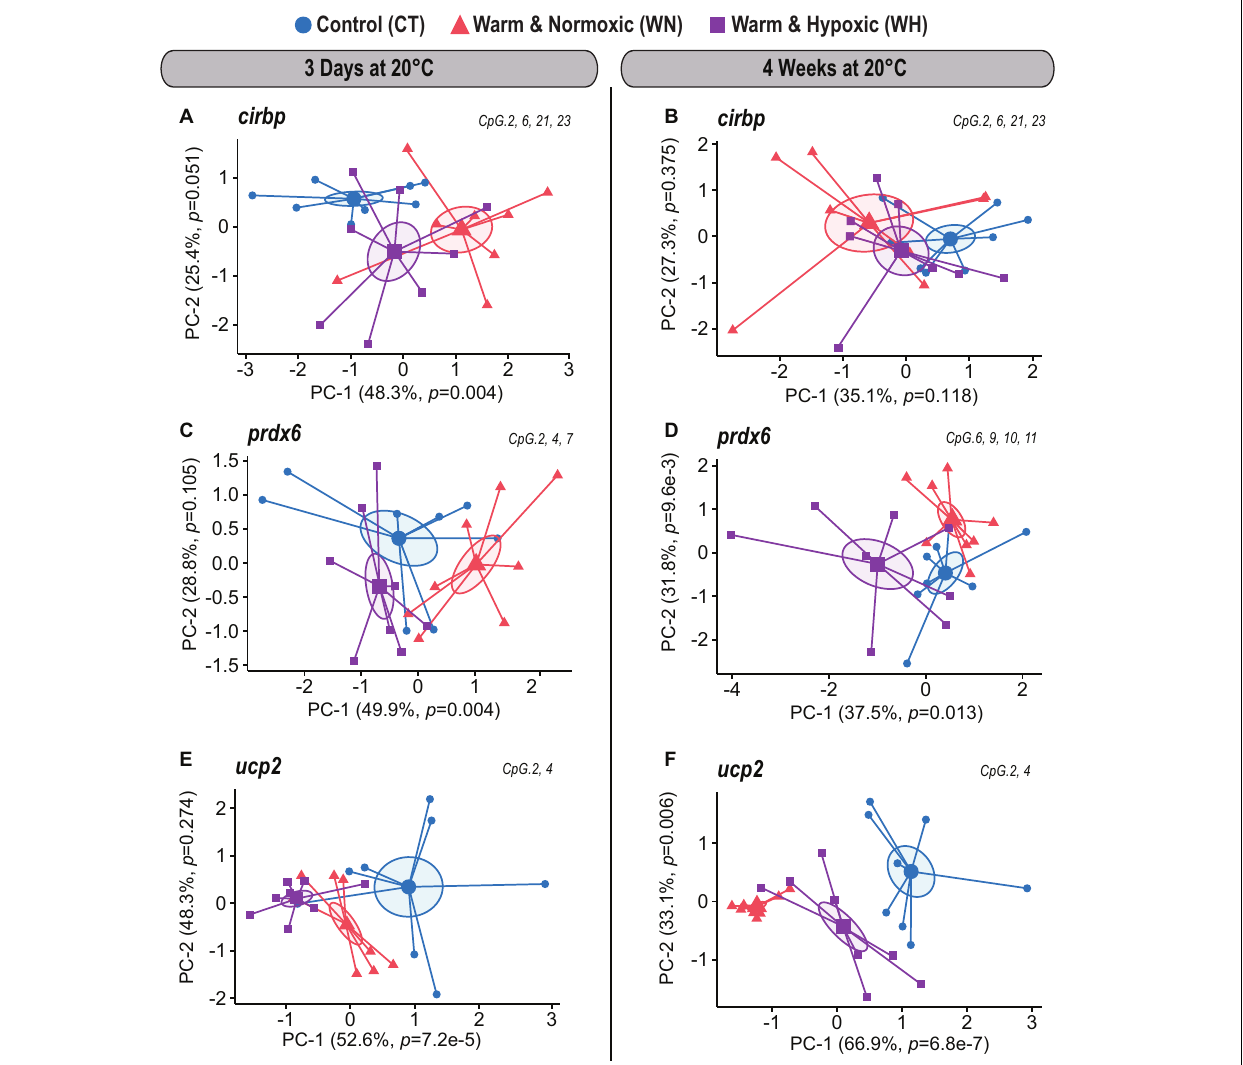
FIGURE 4 | DNA methylation dynamics of responsive CpGs in three genes down-regulated in Atlantic salmon exposed to high temperature and hypoxia. Principal Component Analysis (PCA) on DNA methylation percentages (%) for treatment responsive CpGs from three down-regulated target genes ( cirbp , prdx6 , and ucp2 ) measured in the liver of Atlantic salmon exposed to high temperature alone (WN: 20 ◦ C, ∼ 100% air saturation) or combined with hypoxia (WH: 20 ◦ C, ∼ 70% air sat.) for 3 days or 4 weeks, as compared to control conditions (CT: 12 ◦ C, ∼ 100% air sat.) ( n = 8 per treatment/time point, N = 48 total). PCAs are illustrated separately for each down-regulated gene and exposure time point [ cirbp (A,B) ; prdx6 (C,D) , ucp2 (E,F) ]. PCAs show cluster distribution between the CT, WN, and WH groups with ellipses demonstrating the dispersion of variance and enlarged symbols indicating the center of the distribution for each group. The variances explained by PC-1 and PC-2 are specified in percentage values (%). The p -values represent the treatment effect obtained by applying linear mixed-effect models on the extracted scores of PC-1 and PC-2. Each PCA was based on a specific selection of treatment responsive CpGs as indicated in the upper right corner (see Table 2